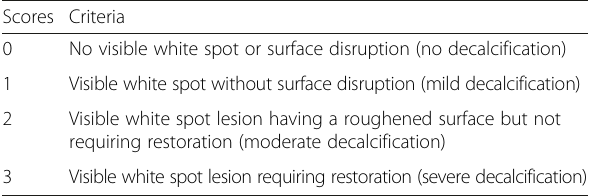
Table 1 Scores and criteria followed for the subjective evaluation of the